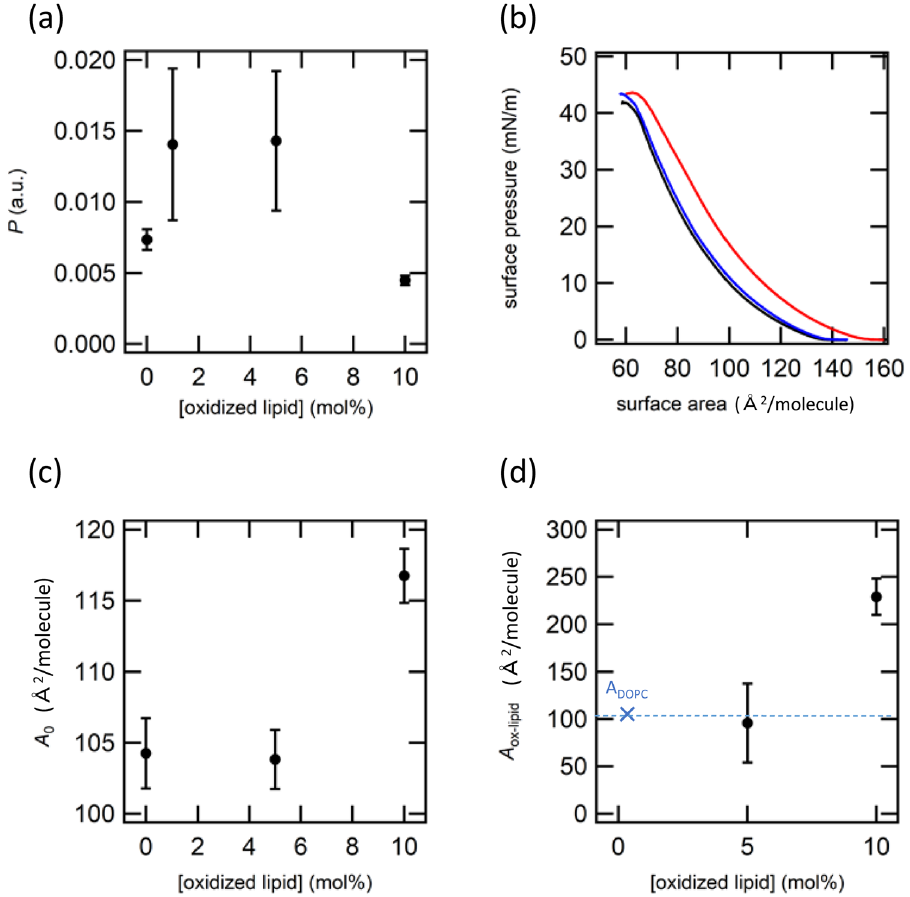
Figure 2. Data for POVPC. The permeation rate P as the function of the concentration of POVPC. ( b ) π – A curves of DOPC/POVPC monolayers. The concentrations of 5CHO-PC are 0 (black), 5 (blue), and 10 (red) mol %. ( c ) Averaged limiting area ( A 0 ) estimated from π – A curves as the function of the concentration of POVPC. ( d ) Calculated limiting area of oxidized lipid ( A ox-lipid ) as the function of the concentration of